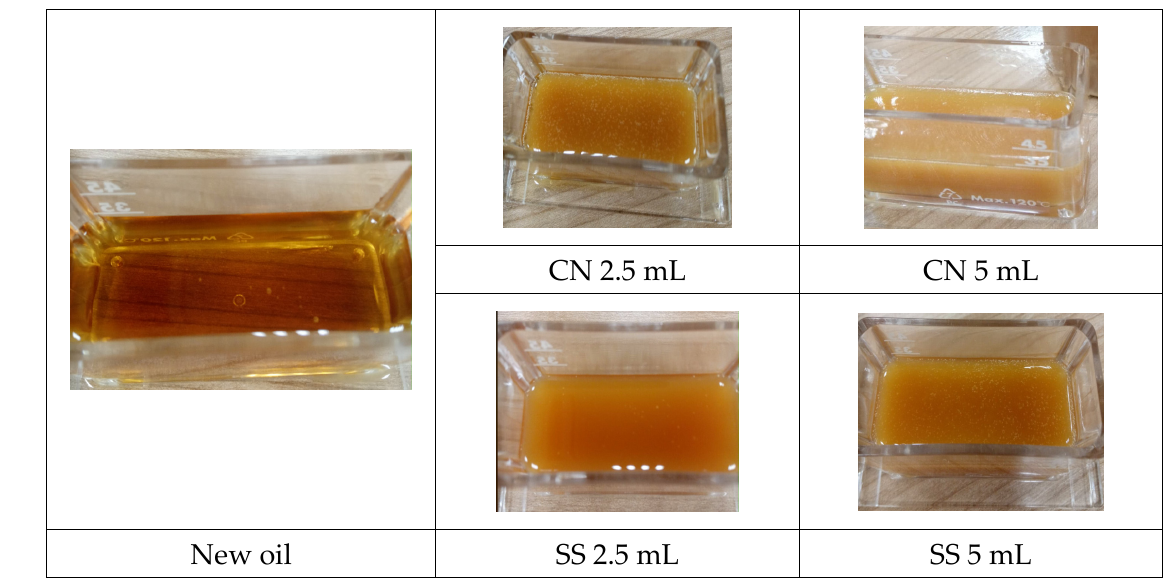
Figure 6. Coloring of new oil, with the addition of silver solution (SS) and colloidal nanosilver (CN)